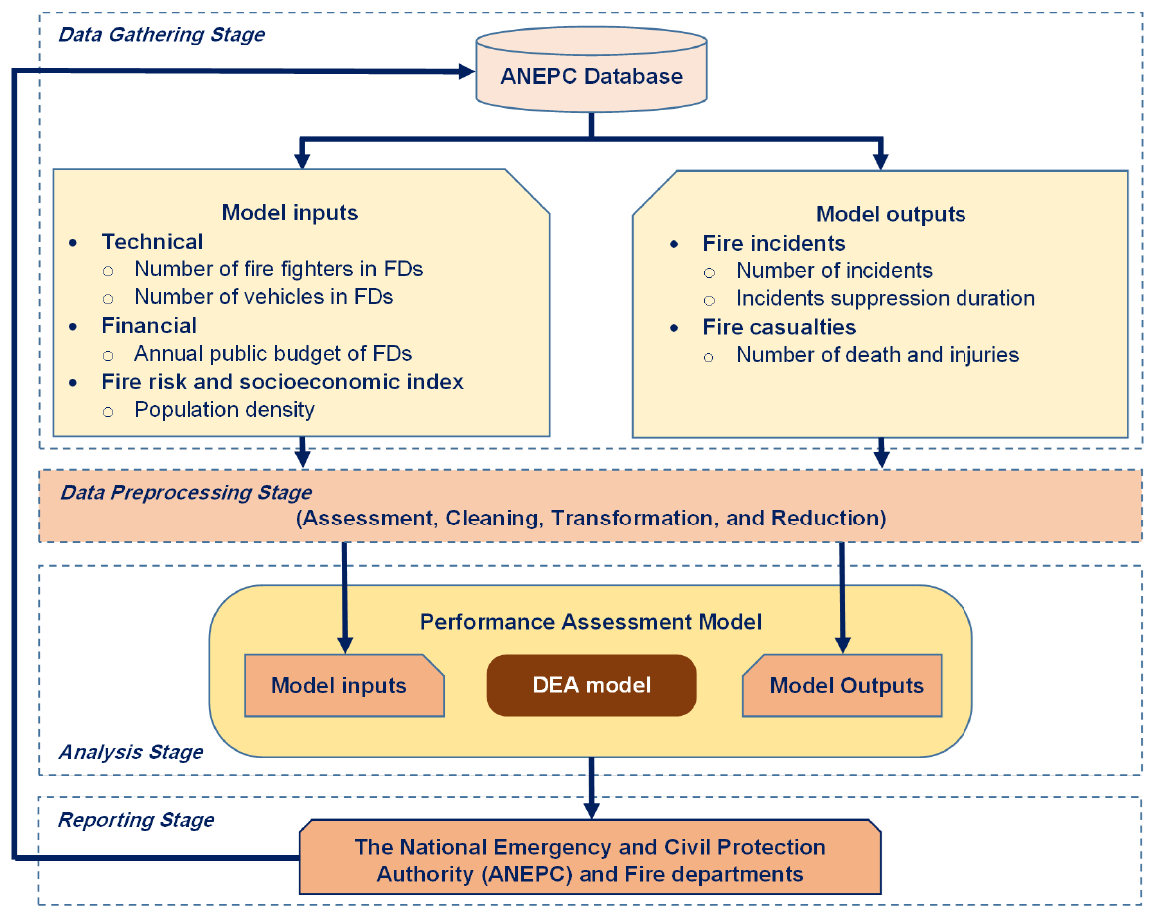
Figure 1. The PT-FDPA model-2020.